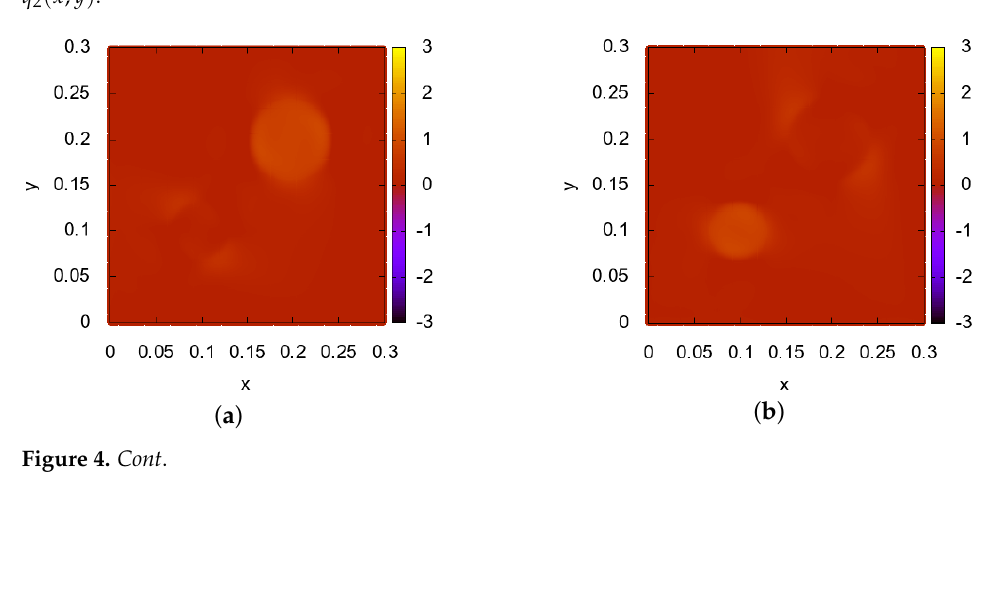
Figure 3. Test 1. Inverse problem 2. Numerical solution. 1500 iterations. Exact data: ( a )—true solu- tion q 1 ( x , y ) , ( b )—true solution q 2 ( x , y ) , ( c )—-computed solution q 1 ( x , y ) , ( d )—computed solution q 2 ( x , y ) .